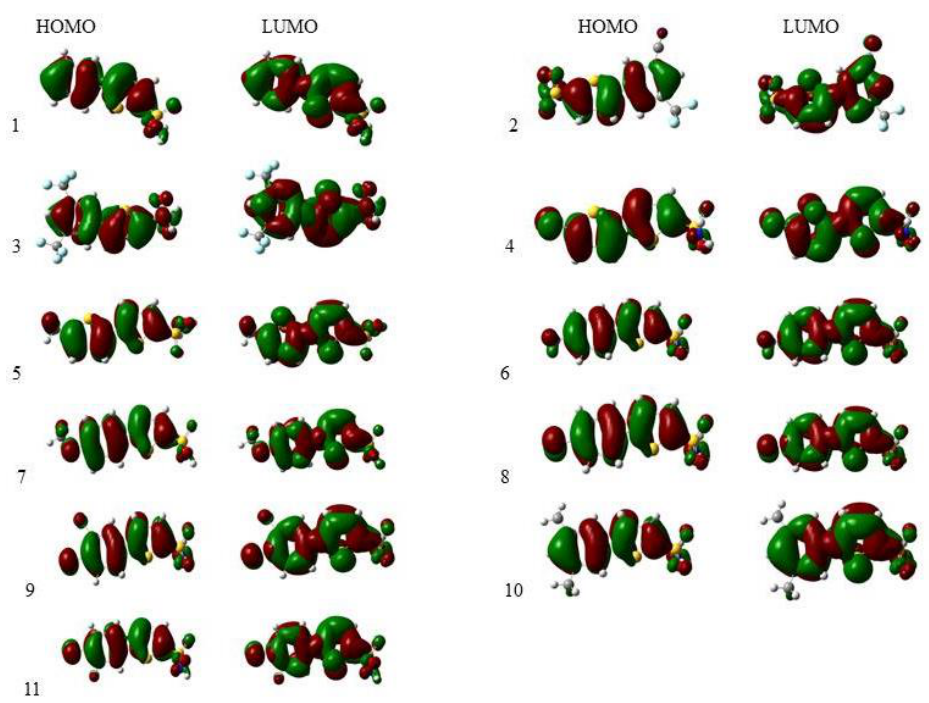
Figure 2. Frontier molecular orbitals of all the compounds under study calculated at the B3LYP/6-311G (d,p)/SMD 1,4-dioxane level of theory.